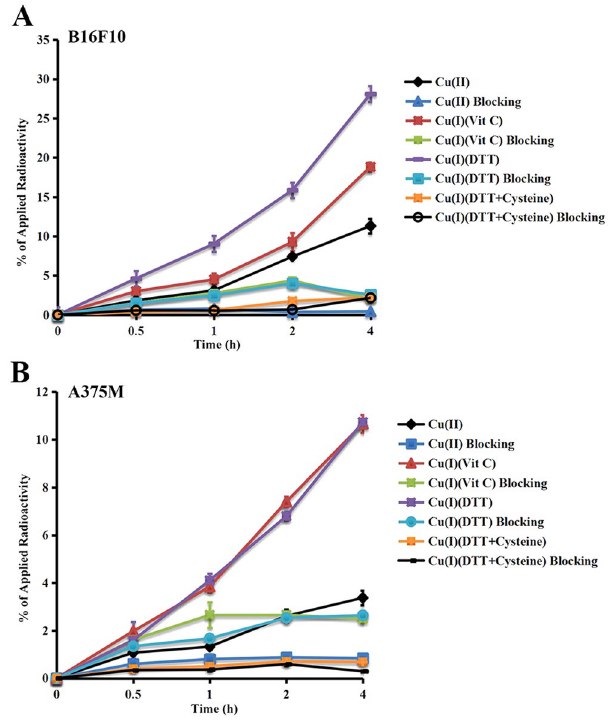
Figure 1. Cell uptake assay of 64 Cu(II) and 64 Cu(I) by B16F10 and A375M cells at 0.5, 1, 2, and 4 h,